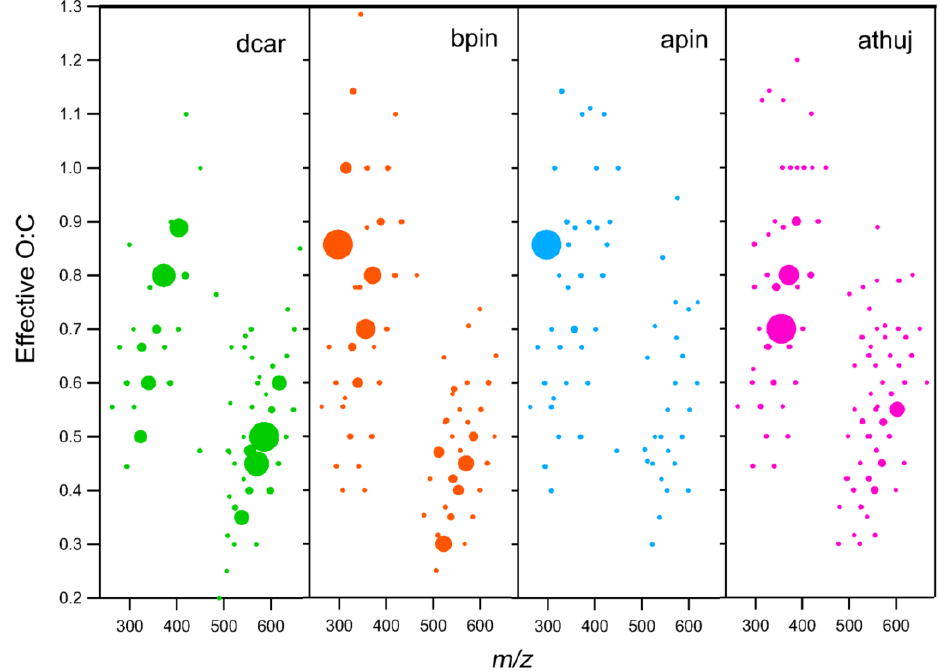
Figure 7. Effective O : C ratio plotted vs. m/z for all measured oxidation products. Plots include oxygen atoms only on the carbon backbone. Each marker represents one compound, and the marker area is proportional to the signal intensity. Note that each MT system is scaled to its own maximum intensity; thus, marker sizes cannot be compared across MT systems. The β -pinene plot shown is for the high-mixing-ratio (70ppb) experiment, and all others are